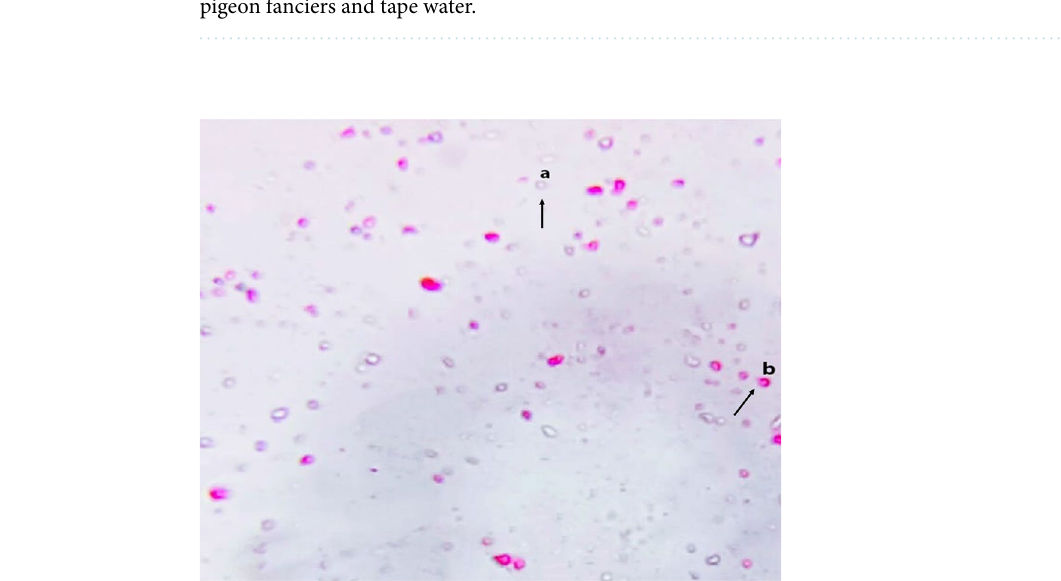
Table 1. Proportion and risk factors associated with Cryptosporidium spp. infection in domestic pigeon, pigeon fanciers and tape water.